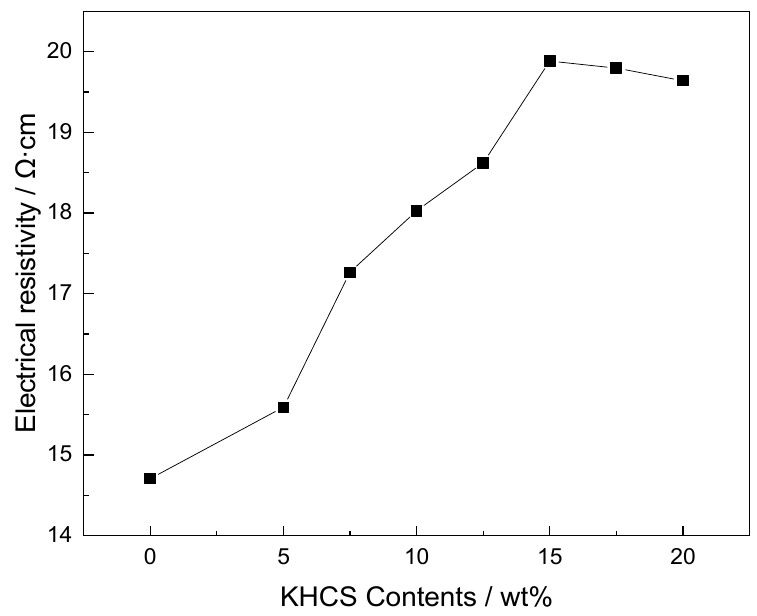
Figure 9. Relationship plot of electrical resistivity and KHCS contents.